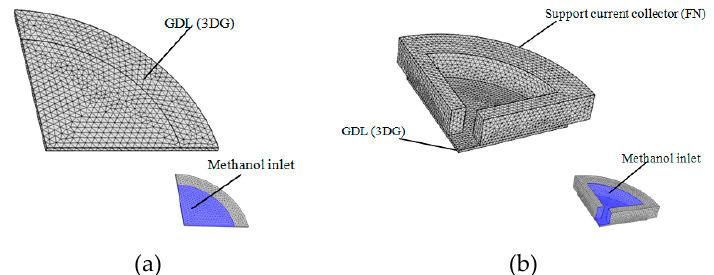
Figure 9. ( a ) The methanol concentration diffusion model of the 3DG + S cell; ( b ) three-dimensional methanol concentration diffusion model of the FN + 3DG cell. Table 4. Main geometric parameters and working parameters of the B- µ DMFC model.